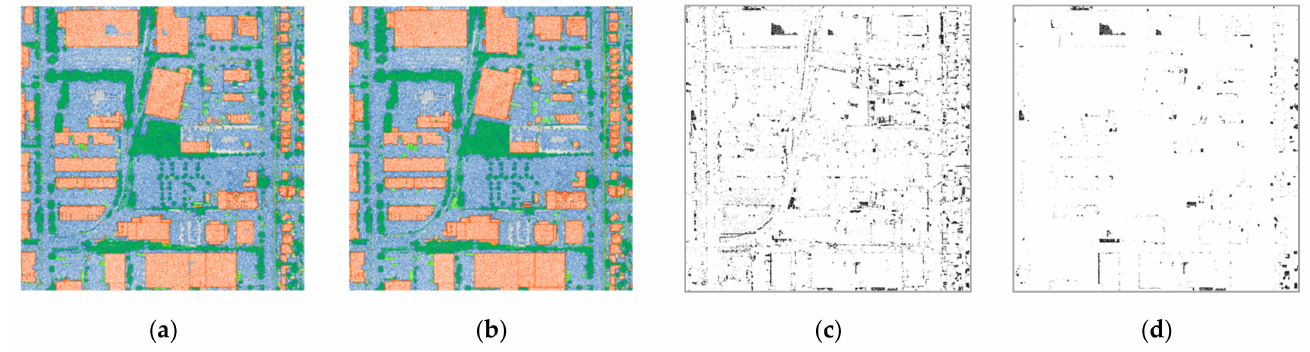
Figure 20. Results of semantic segmentation of test data 2 for Case 2: ( a ) prediction; ( b ) ground truth (i.e., label data); ( c ) difference between prediction and ground truth for all classes; ( d ) difference between prediction and ground truth for building class only.